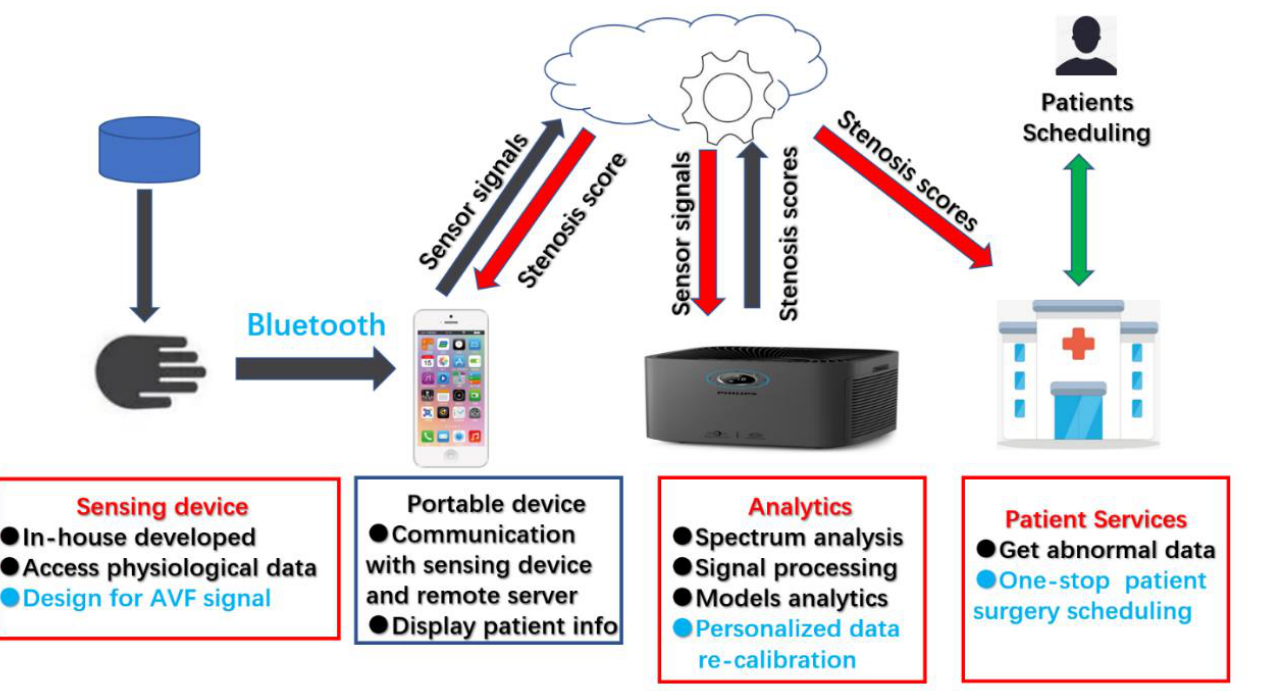
Figure 5. Hand Function Rehabilitation